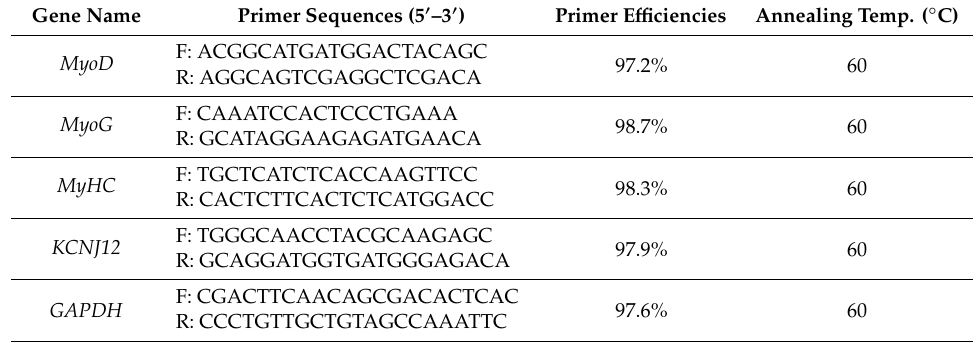
Table 2. PCR primer sequences of KCNJ12 and GAPDH gene in cattle for quantitative polymerase chain reaction (qPCR).